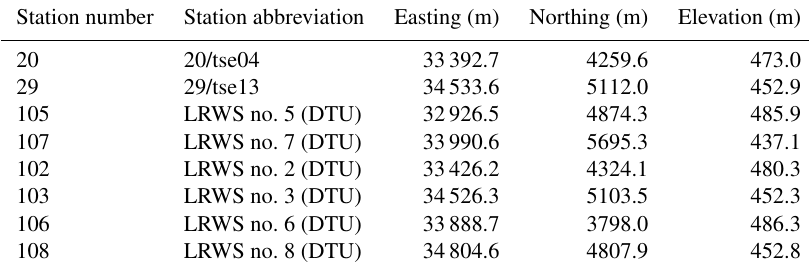
Figure 1. (a) Elevation map of the Perdigão site. Measurement transects are indicated by the solid blue (transect 1), dashed red (transect 2) and dotted black (transect 3) lines. Black disks: WindScanner positions; numbers: WindScanner station numbers as in Table 1; black + symbol: wind turbine position; white X symbols: position of measurement masts used in this investigation. PT-TM06/ETRS89 coordinate system, height above sea level. (b) Distribution of 30min averaged wind measurements taken by the 100m anemometer on the mast located on the northeast ridge over the period from 1 April to 15 June 2017. Measurements are in ms − 1 . Table 1. Positions of instruments used in this study. Easting and northing are in the PT-TM06/ETRS89 coordinate system and elevation is above sea level. Elevation of the masts (first two rows) refers to the mast base and elevation of the WindScanners (remaining rows) refers to the scanner head position. LRWS indicates long-range WindScanners. Station number Station abbreviation Easting